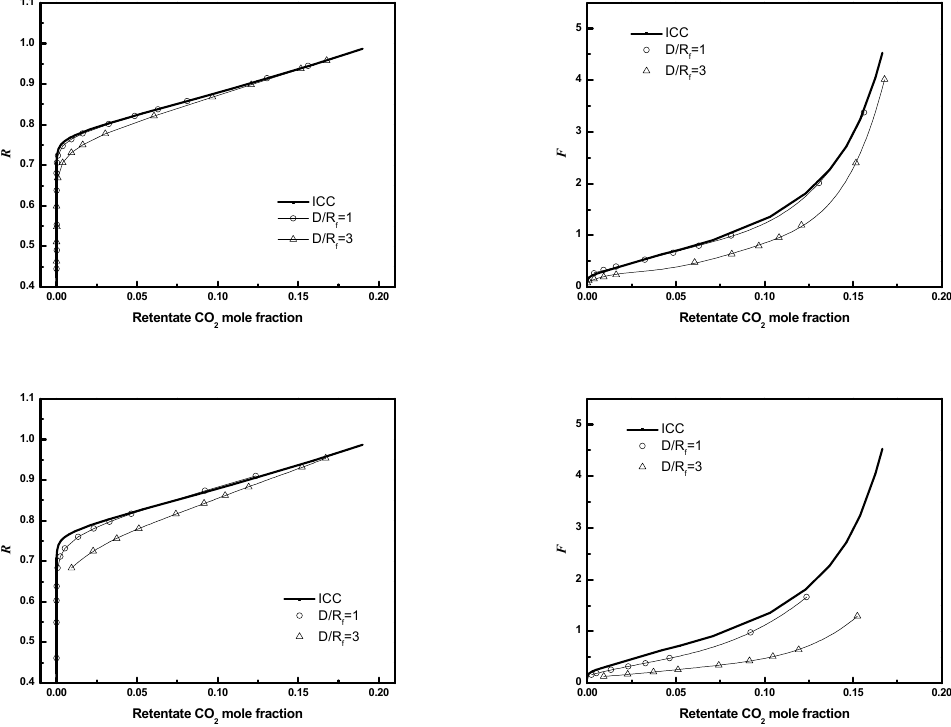
Figure 18. R or F as a function of CO 2 mole fraction for module with different D/R f . Top ( N = 405, φ = 0.4), bottom ( N = 405, φ = 0.6). Circle, D/R f = 1; up triangle, D/R f = 3; solid line, ICC.